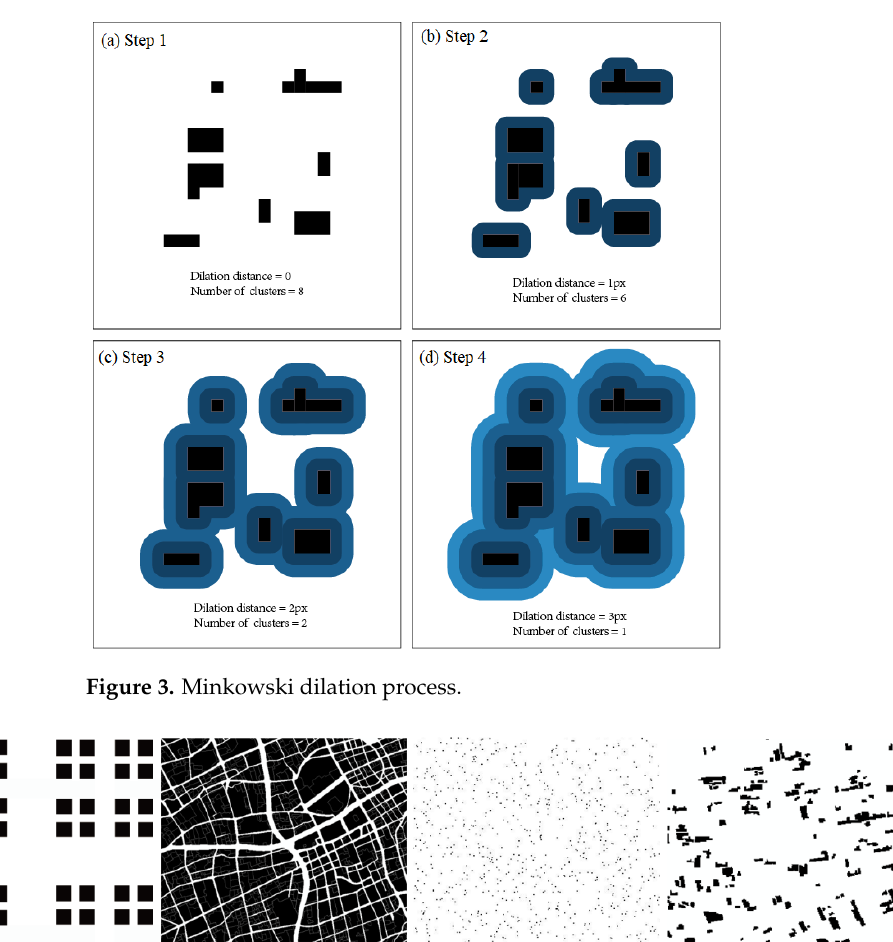
Figure 3. Minkowski dilation process.